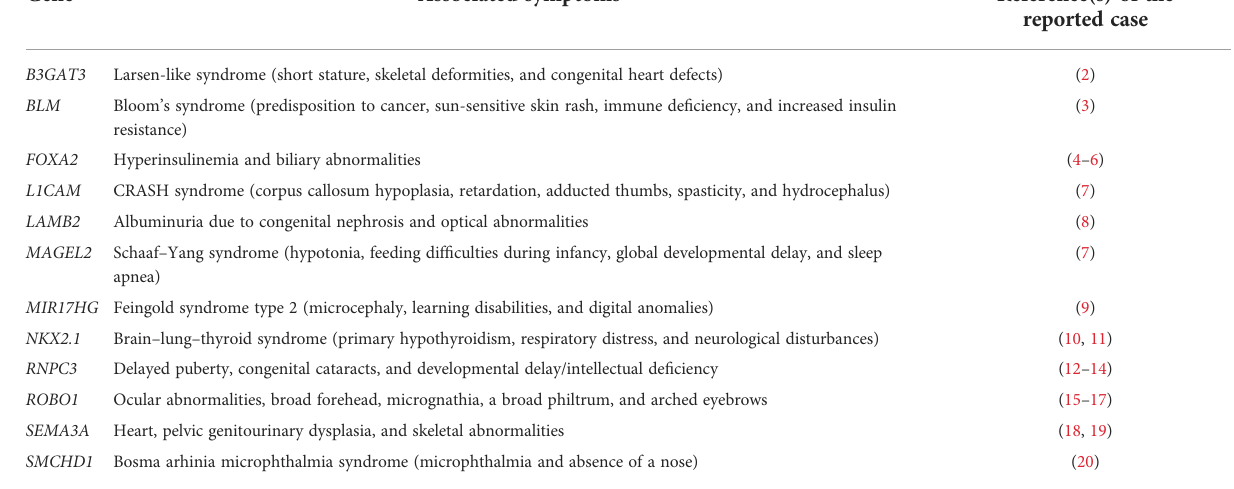
TABLE 1 Characteristics of extra-pituitary